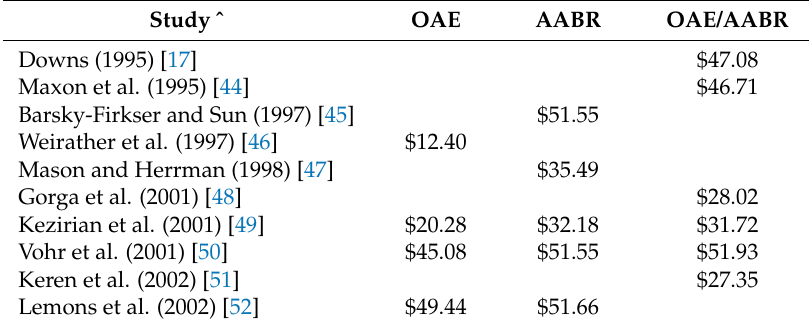
Table 1. US micro-costing studies estimating inflation-adjusted cost (in 2016 US$) of pre-discharge hospital-based newborn hearing screening in well-baby units, by type of screening algorithm (does not include post-discharge testing or diagnostic costs). Study ˆ OAE